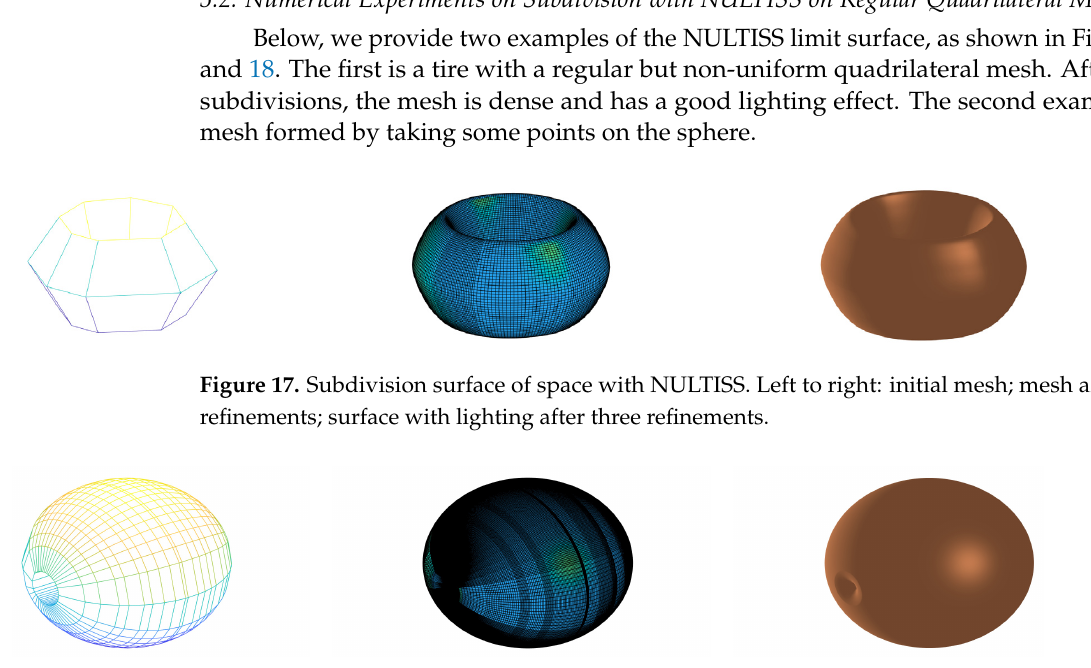
Figure 18. Subdivision surface of space with NULTISS. Left to right: initial mesh; mesh after two refinements; surface with lighting after three refinements.